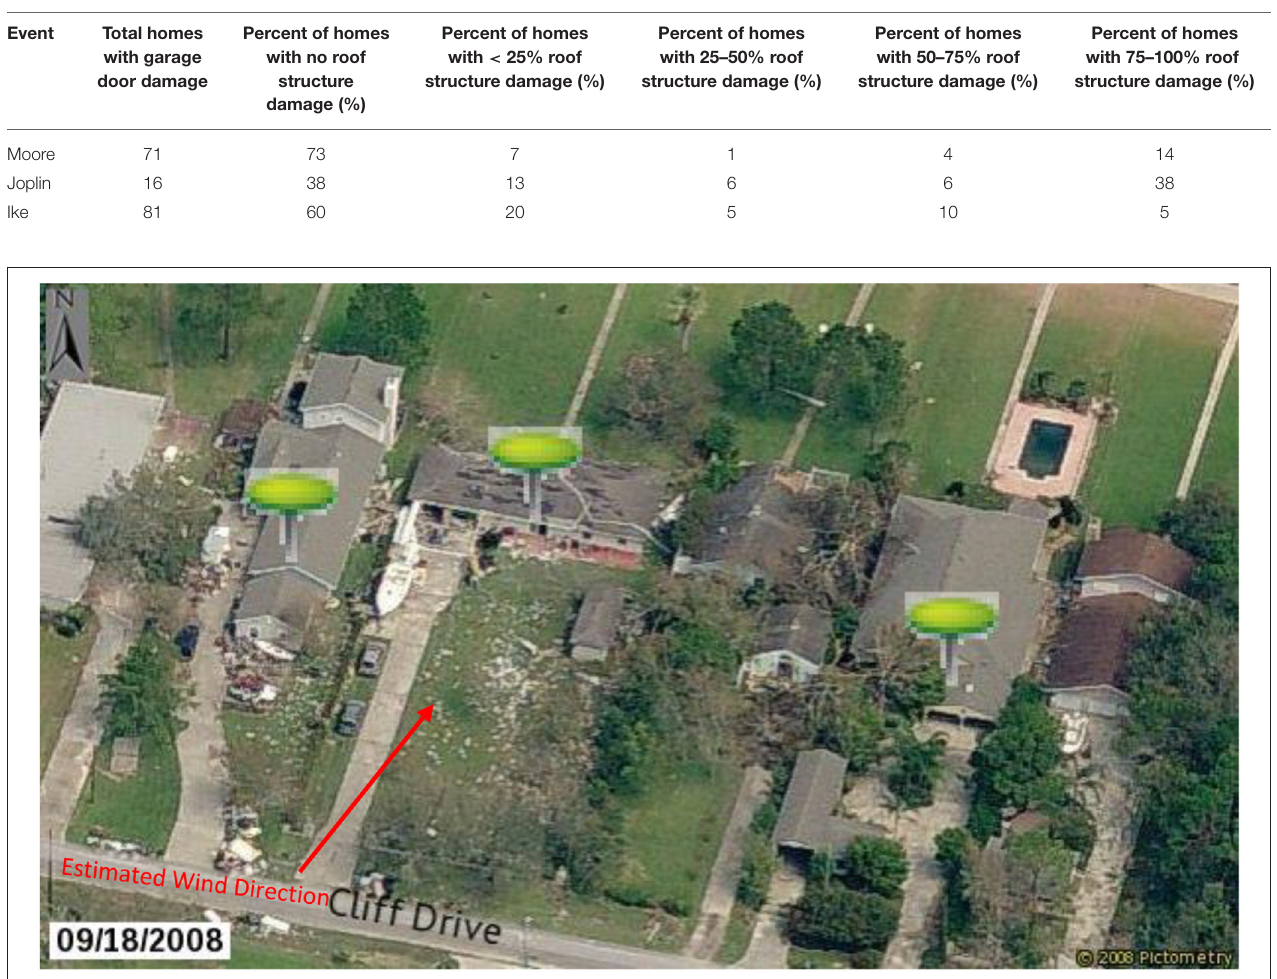
TABLE 5 | Roof structure damage severity in 90–109 mph wind speed range.